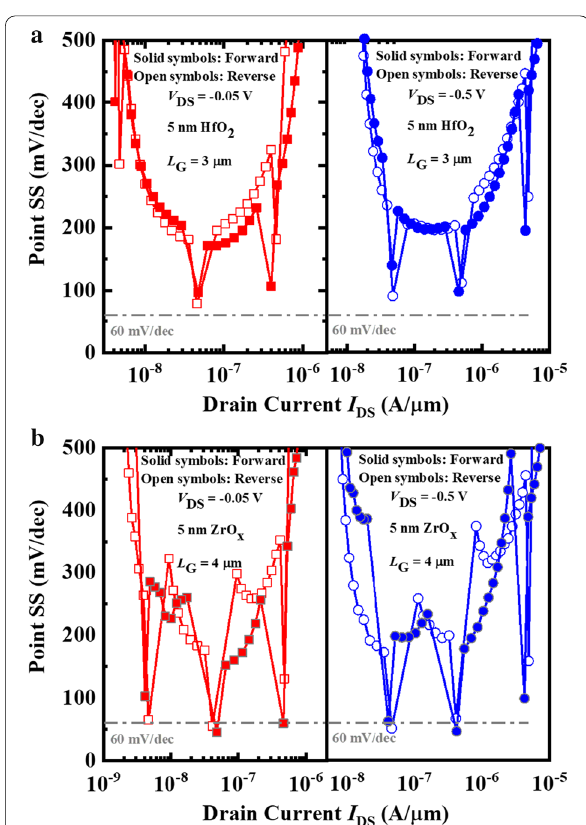
Fig. 5 Point SS as a function of I DS for the a Al 2 O 3 /5 nm HfO 2 NCFETs and b 5 nm ZrO x